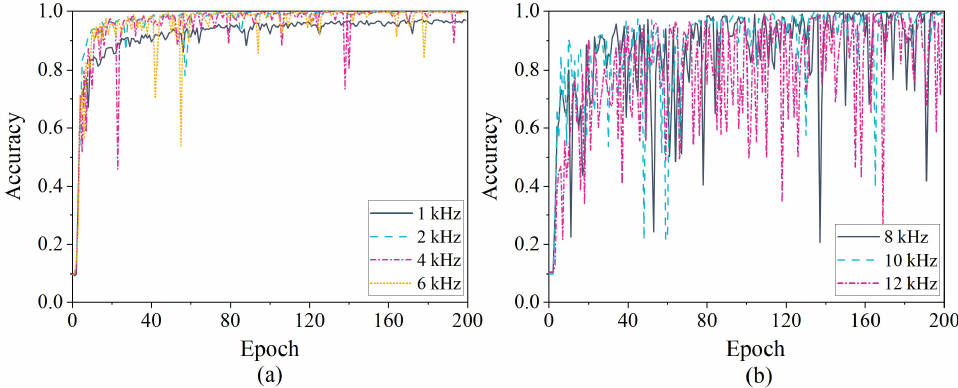
Figure 10. The validation accuracy of Dataset A ( a ) 1 kHz, 2 kHz, 4 kHz, and 6 kHz, ( b ) 8 kHz, 10 kHz, and 12 kHz.